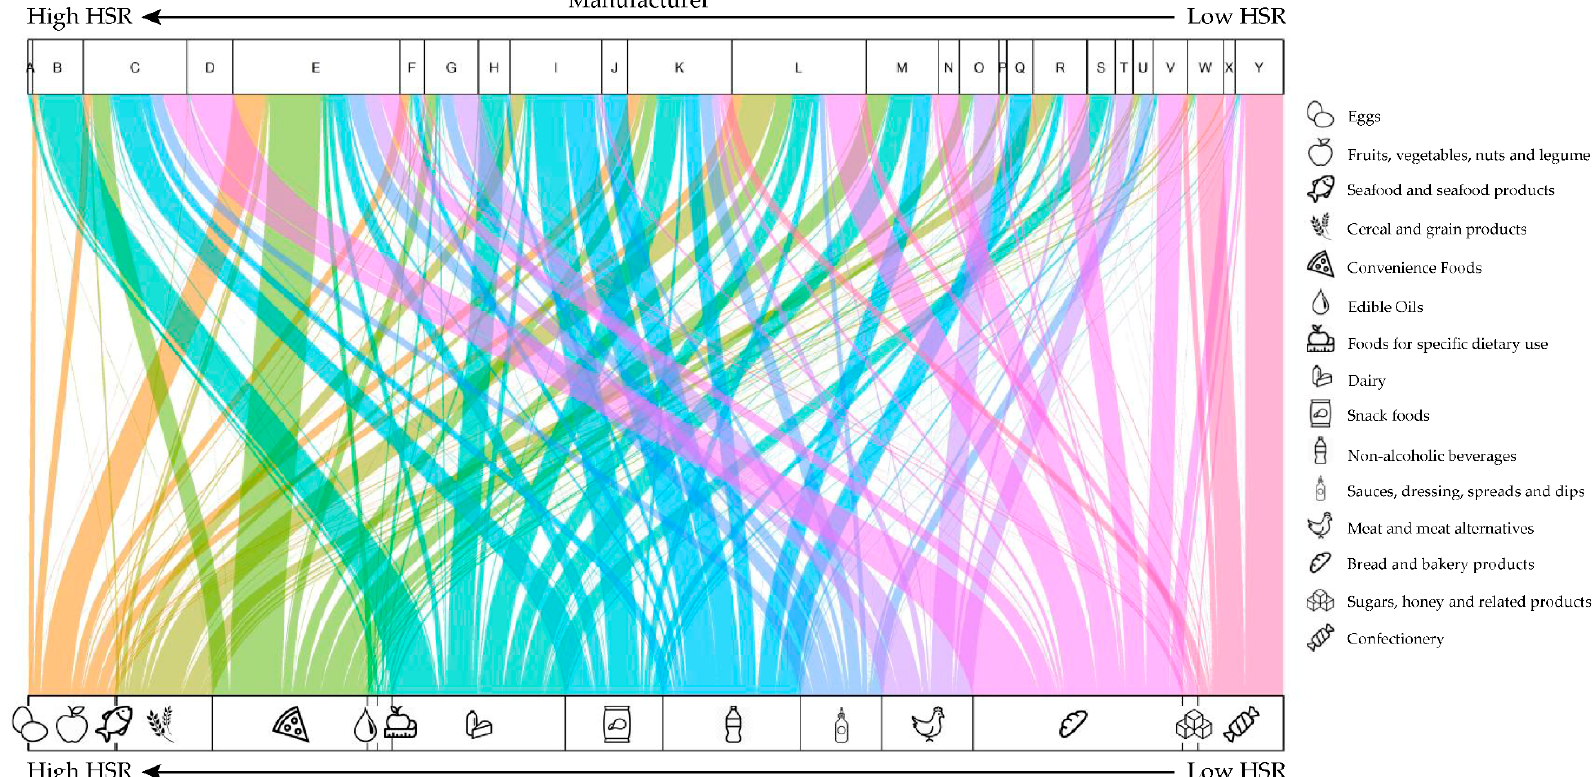
Figure 2. Alluvial plot demonstrating top 25 (A–Z) US manufacturers’ product portfolio compositions by mean Health Star Rating (HSR) and major food category. Colors represent major food categories identified by icons.